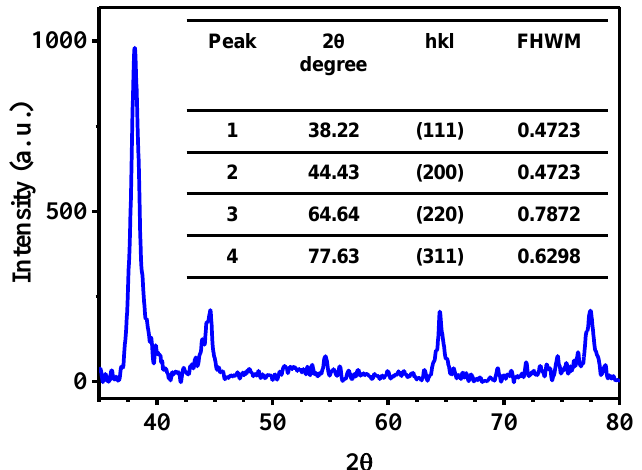
Figure 2. X-Ray diffraction pattern of AuNPs synthesized with water/ethanol Sargassum spp. extract.